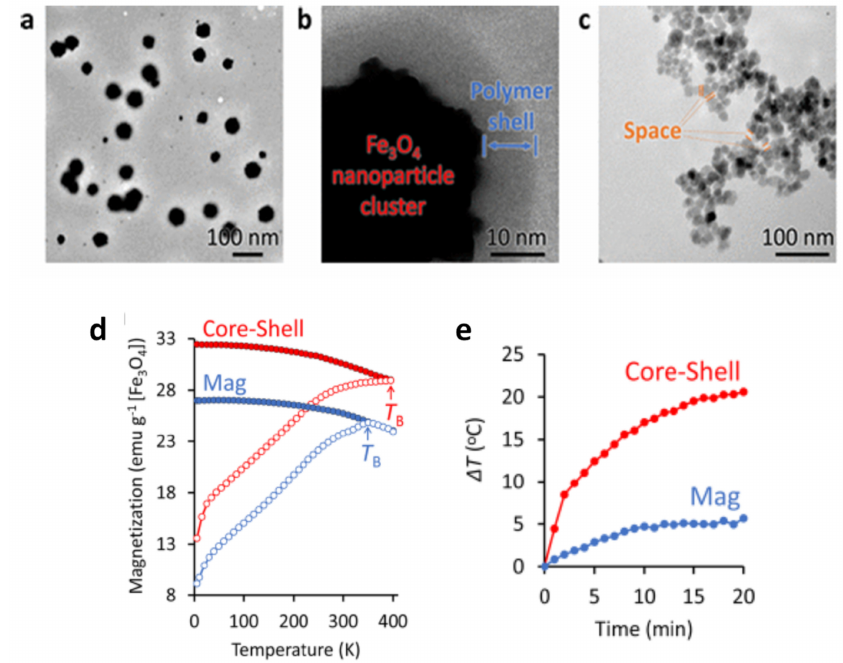
Figure 8. ( a ) TEM image of magnetite MC_NPs ( b ) Magnified view of a MC_NP allowing to distinguish the existence of a 6 nm-thick polymer shell. ( c ) TEM image of unclustered Fe 3 O 4 NPs, prepared as control material. ( d ) ZFC-FC magnetization measurements vs. T measured on the MC_NPs (indicated as core-shell sample due to the presence of the polymer coating) and on the control NPs (sample called Mag). ( e ) Changes in the temperature of an aqueous solution containing MC_NPs and the control NPs with AMF application time. Adapted with permission from Ref. [194], Copyright 2016 American Chemical Society (further permissions related to the material excerpted should be directed to the